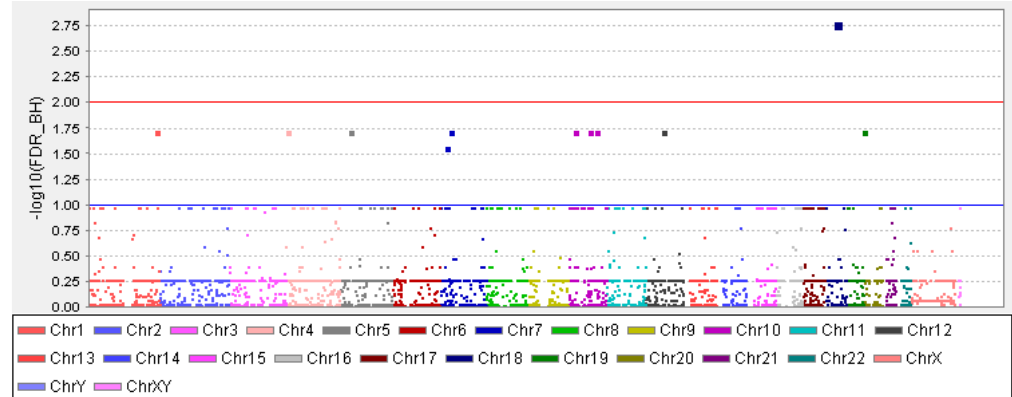
Figure 1. Manhattan plot with a blue line and red line indicating the threshold for genome ‐ wide significance. The x ‐ axis has the chromosome numbers and ‐ log 10 FDR–BH (false discovery rate–Benjamini and Hochberg) adjusted p ‐ value in the y ‐ axis. Table 1. List of SNPs that showed a significant association with an orofacial cleft in GWAS. S.